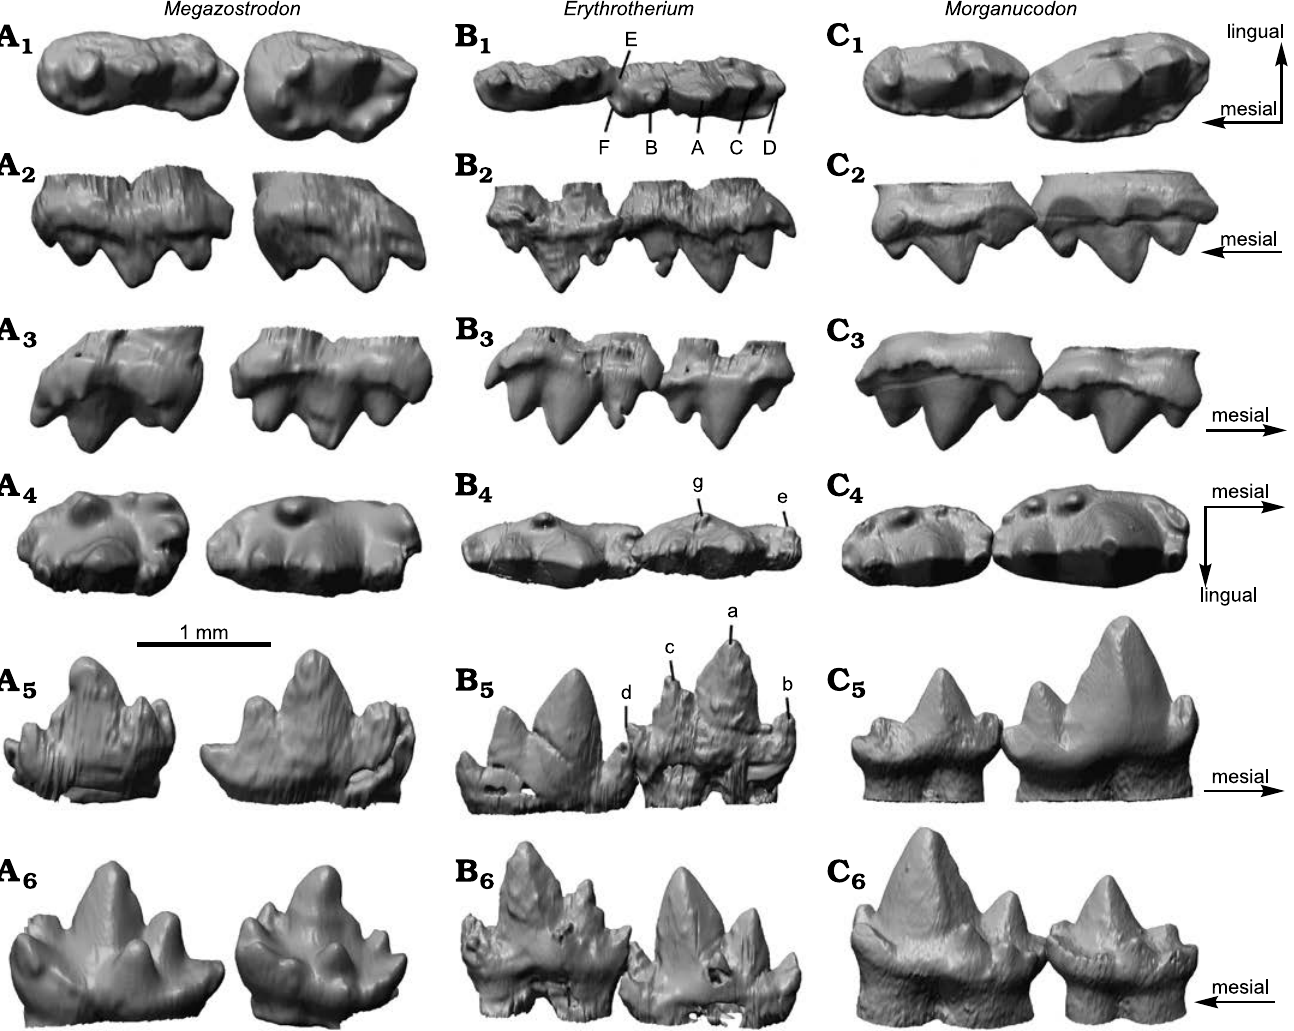
Fig. 1. Upper and lower molar comparison of morganucodontan mammaliaforms Megazostrodon rudnerae (Crompton and Jenkins, 1968), NHMUK PV M26407; Early Jurassic, Lesotho, Red Bed Series ( A ), Erythrotherium parringtoni (Crompton, 1964) SAM-PK-K00359; Late Triassic, South Africa, Mafeteng locality, Upper Red Beds ( B ), and Morganucodon watsoni (Kühne, 1949) UMZC Eo.CR.1; Early Jurassic, United Kingdom, Glamorgan fissure systems, Pontalun 3 ( C ). M1 and M2 in occlusal (A 1 , B 1 , C 1 ), lingual (A 2 , B 2 , C 2 ), and buccal (A 3 , B 3 , C 3 ) views. m2 and m3 in occlusal (A 4 , B 4 , C 4 ), buccal (A 5 , B 5 , C 5 ), and lingual (A 6 , B 6 , C 6 ) views. Fig. 2. Comparison of the occlusal hypothesis for m2–m3 and M1–M2 of morganucodontan mammaliaforms Erythotherium parringtoni (Crompton, 1964), SAM-PK-K00359; Late Triassic, South Africa, Mafeteng locality, Upper Red Beds ( A ), Morganucodon watsoni (Kühne, 1949), UMZC Eo.CR.1; Early Jurassic, United Kingdom, Glamorgan fissure systems, Pontalun 3 ( B ), and m1–m2, P5 and M1 of Megazostrodon rudnerae (Crompton and Jenkins, 1968),